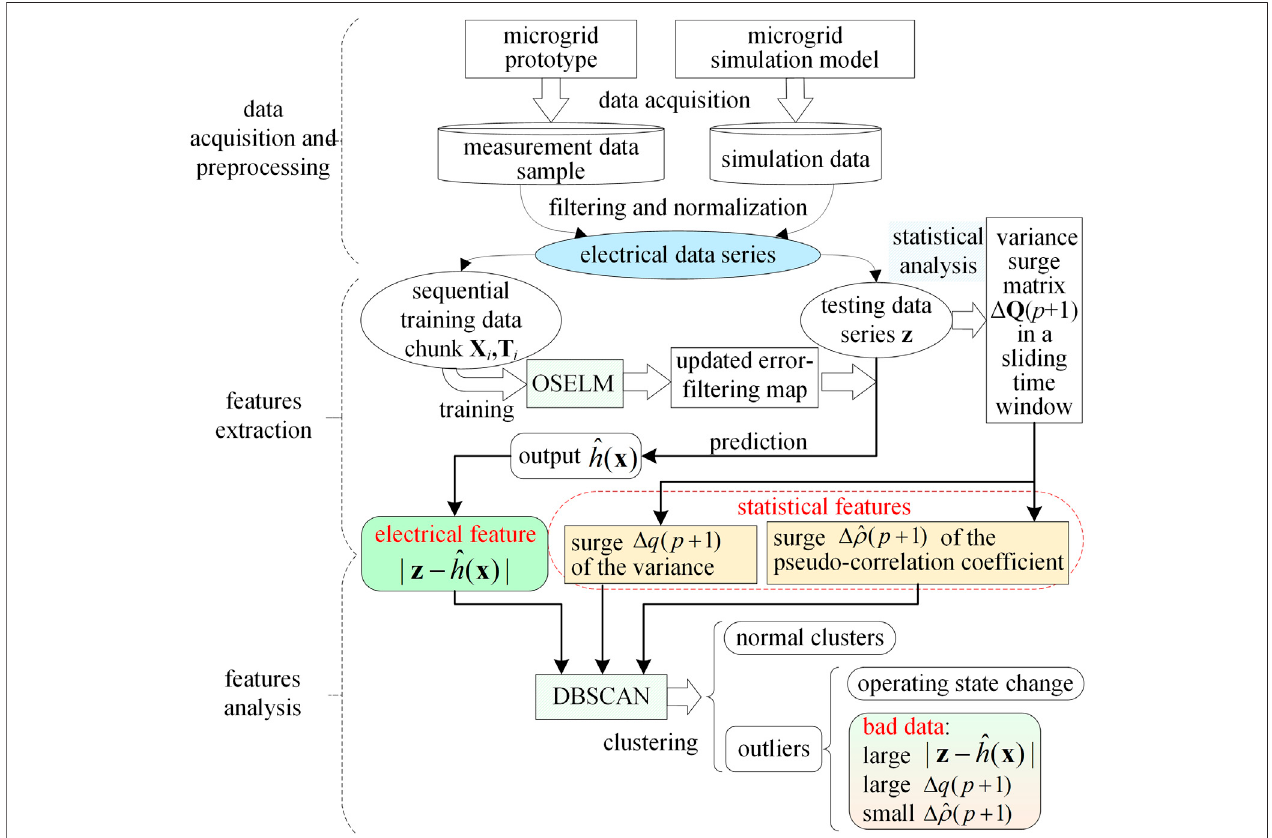
FIGURE 6 | Flow chart of the proposed